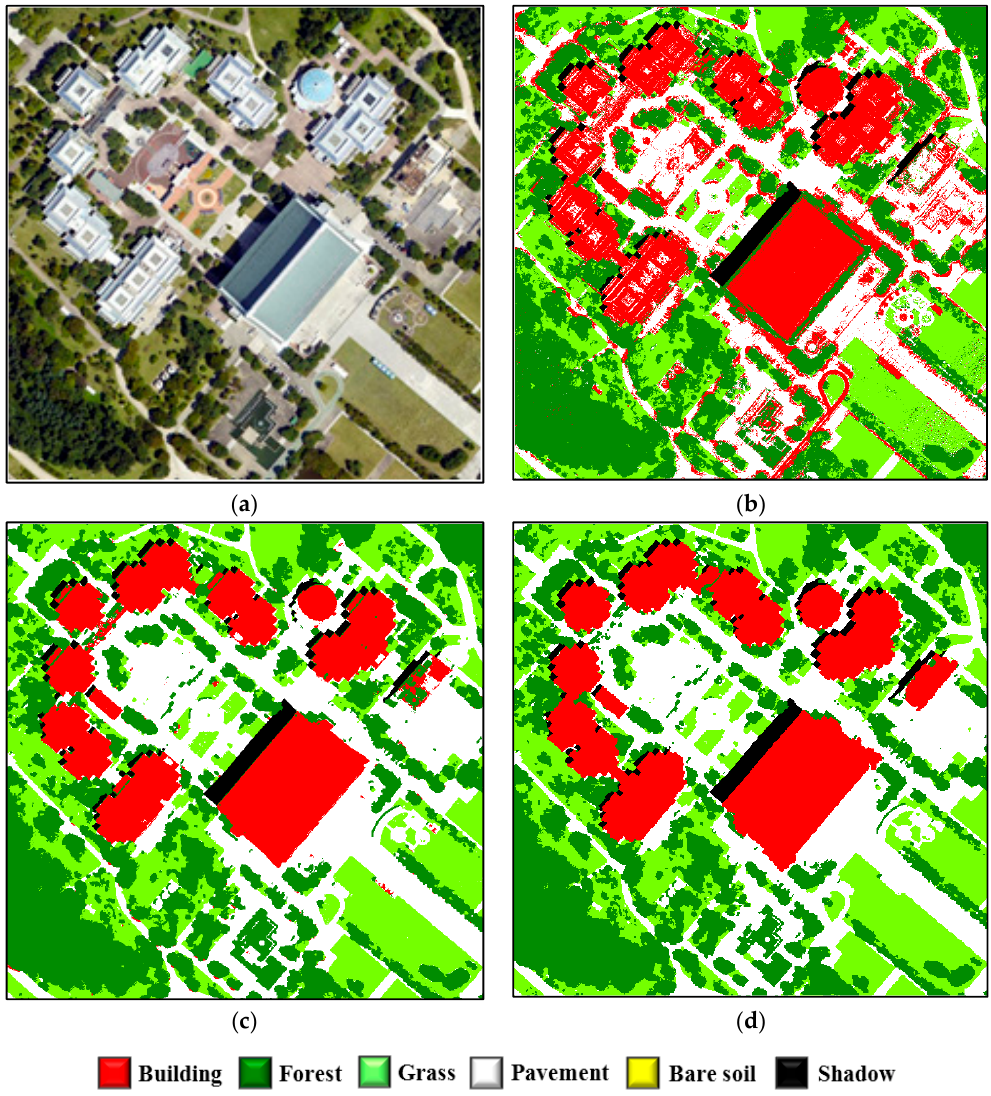
Figure 6. Final results for site 1: ( a ) aerial image; ( b ) Max-Min method; ( c ) SSI, nDSM method; and ( d ) the new method.